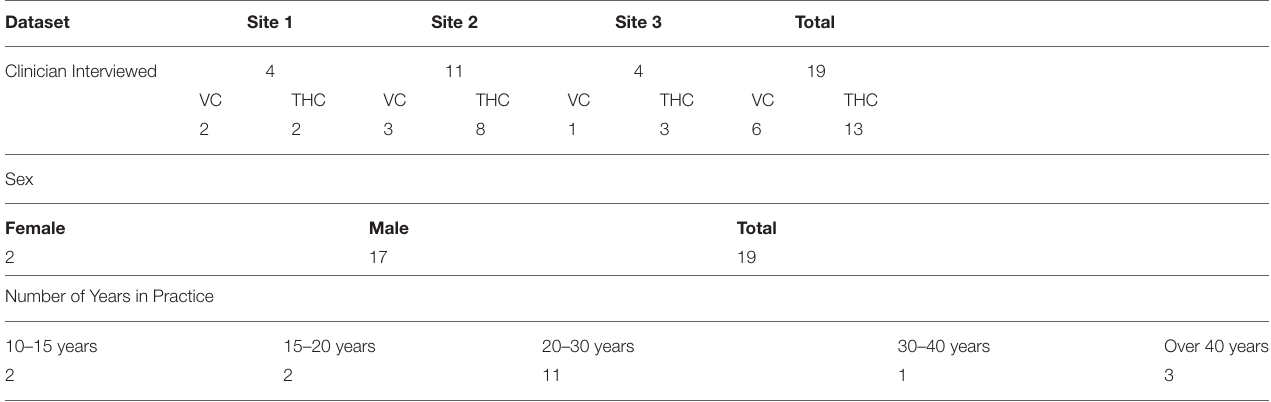
TABLE 1 | Summary of sample demographics.